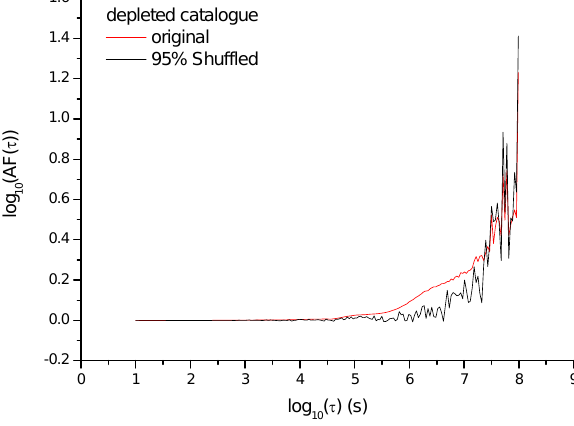
Fig. 11 Fig. 11. Comparison between the AF curve for the aftershock- depleted catalogue (black line) and the 95% confidence curve (red line) obtained by means of generation of 1000 randomly shuffled